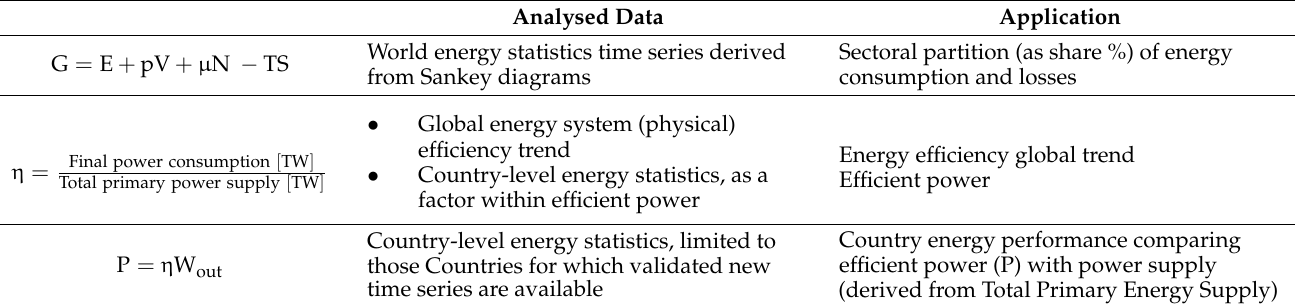
Table 1. Equations applied to analyzed IEA datasets, and their purpose of application. Please, note that the chosen efficiency indicator parallels, not being alternative to, the key indicator of efficiency, as defined in classical equilibrium thermodynamics, calculated as the ratio of net work and heat